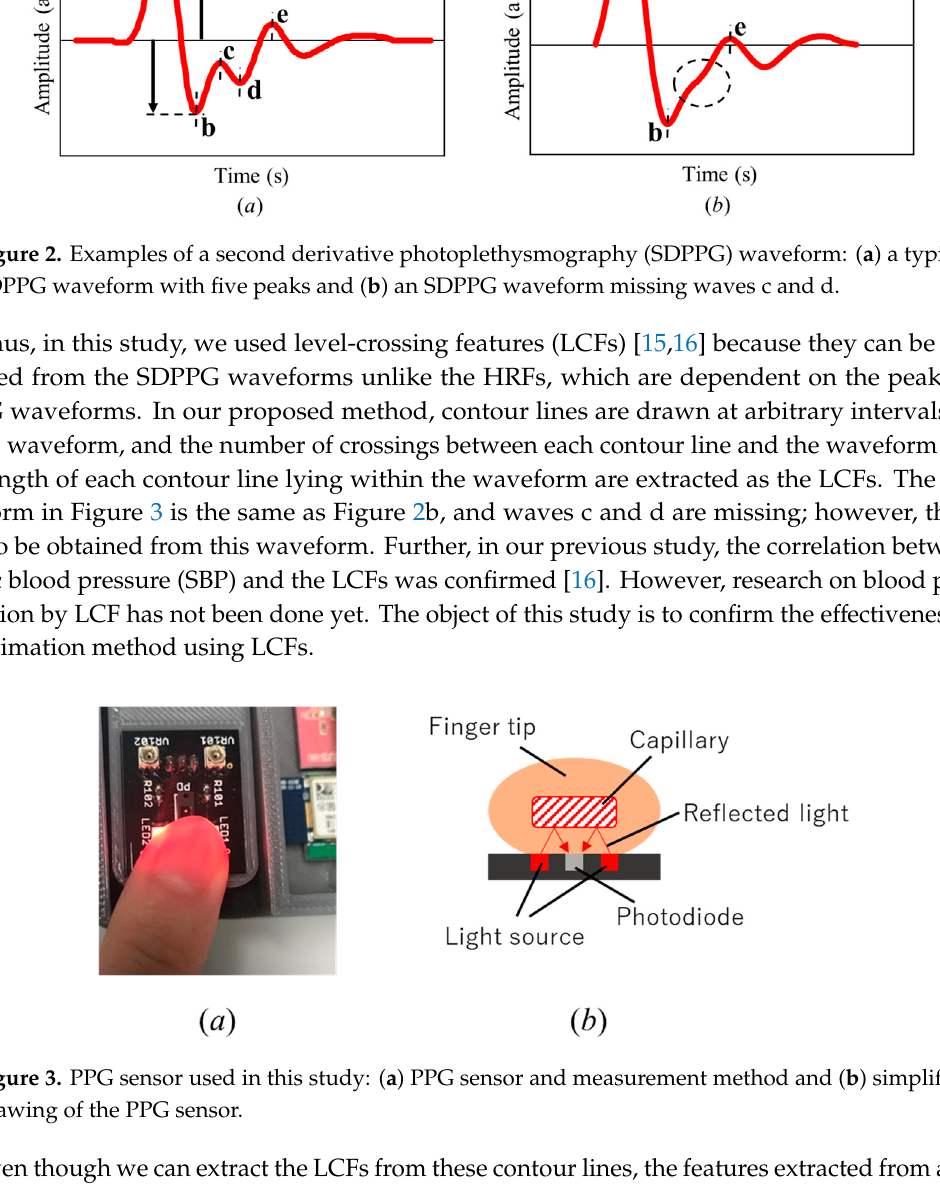
Figure 1. Photoplethysmography (PPG) waveform and its derivative waveforms: ( a ) PPG waveform,